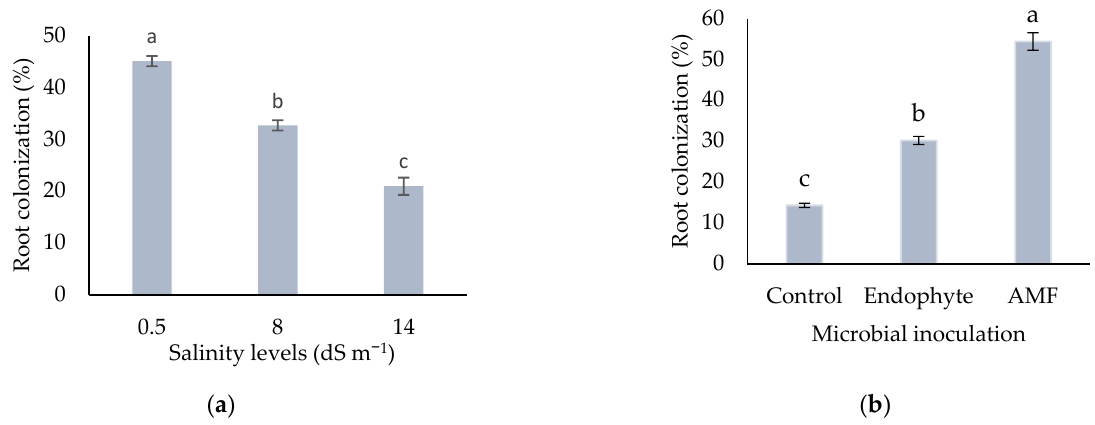
Figure 4. The effect of ( a ) salinity levels and ( b ) microbial inoculation on root colonization. Bars show the means ± standard error of the mean. Means with a different letters indicate significantly different values at p < 0.05 based on Duncan’s multiple range test.